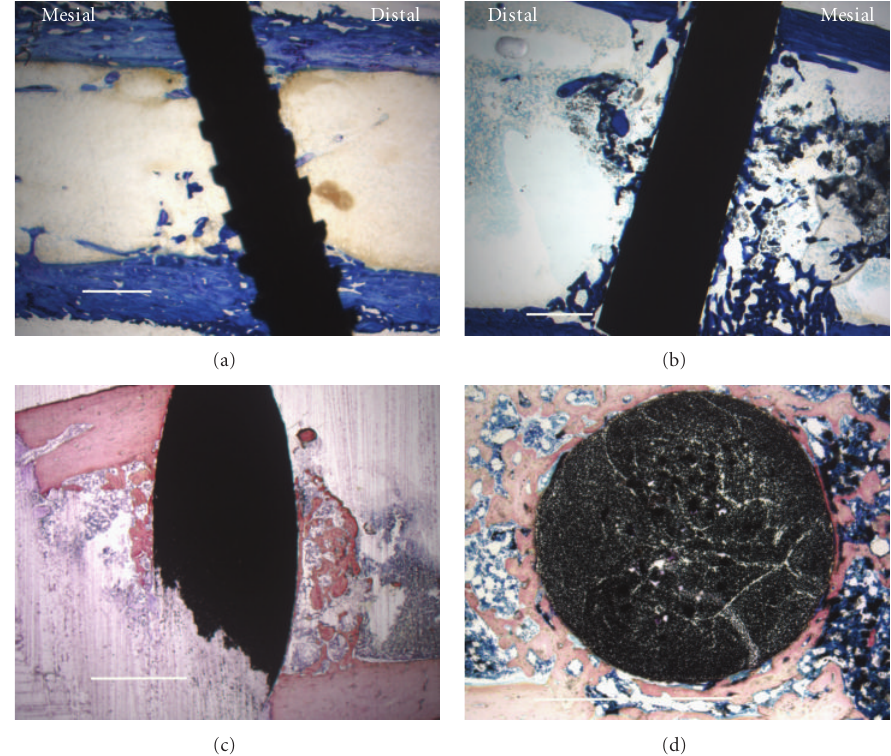
Figure 4: Histological low-magnification imaging with all scale bars approximately 1.0mm. (a) Lateral section of titanium-6-4 alloy implant as a representative image at the 0.8mm implant distance (7.1 PBA from 10.5 PBA average) with toluidine blue stain. (b) Lateral section of bisphenyl-polymer/carbon-fiber composite implant was chosen as a representative image at the 0.8mm implant distance (42.3 PBA from 41.6 PBA average) with toluidine blue stain. (c) Lateral intramedullary section of a bisphenyl-polymer/carbon-fiber composite